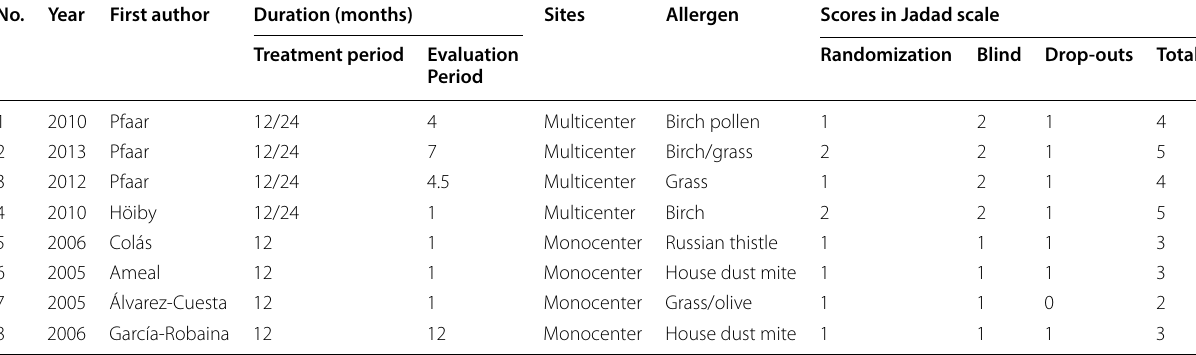
Table 2 Main methodological characteristics of included